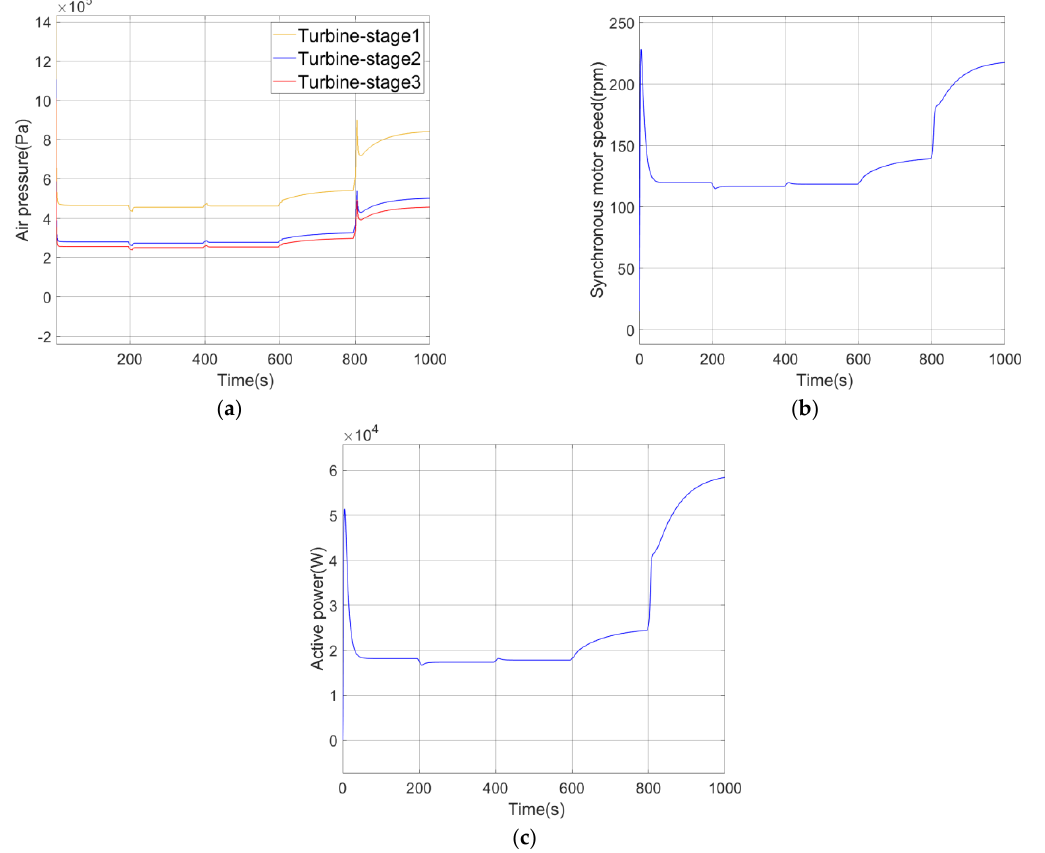
Figure 40. Simulation results of AA-CAES system participating in microgrid voltage regulation under light fluctuation: ( a ) Change in air pressure in cylinder of piston compressor; ( b ) Speed change in synchronous generator; ( c ) Change in power generated by the system.